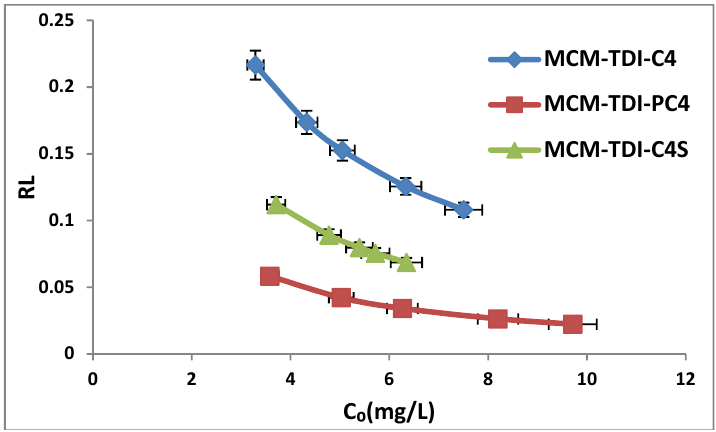
for adsorption of TBT onto MCM-TDI-C4, MCM-TDI-C4S and L